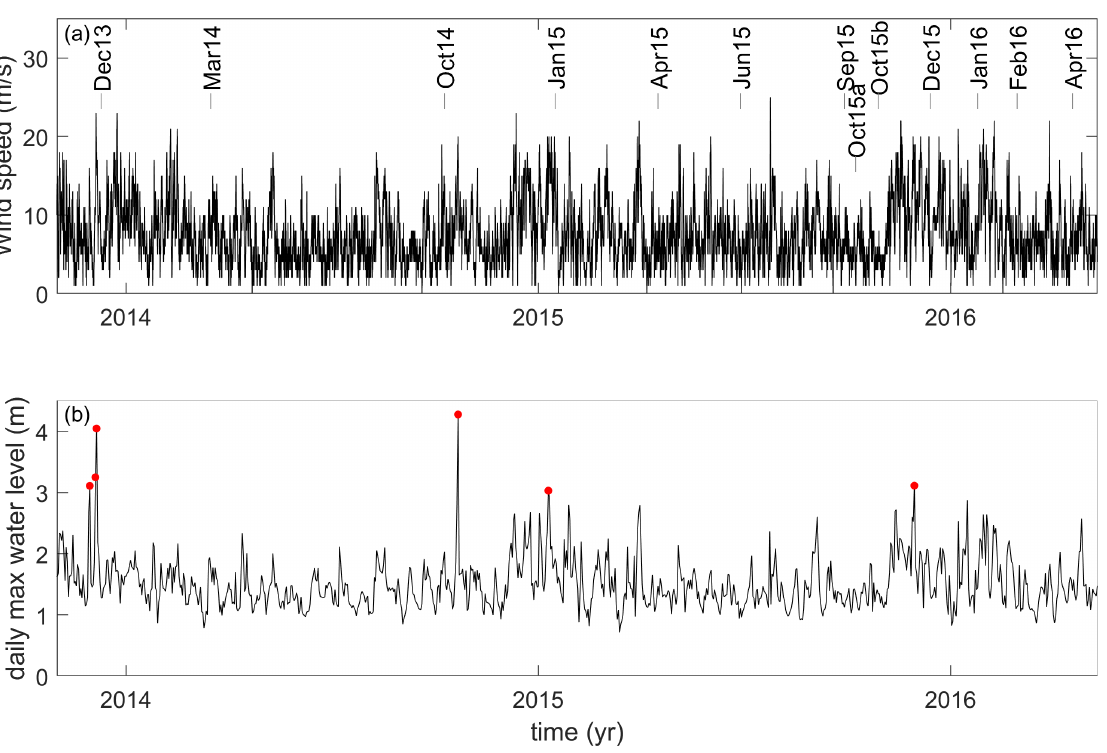
Figure 6. Environmental conditions during the measurement period. ( a ) shows the absolute wind speed; scan dates are indicated; ( b ) shows the maximum daily water level including the effects of set-up and run-up. Days where water levels reached above the height of the dune foot (+3 m) are marked with red